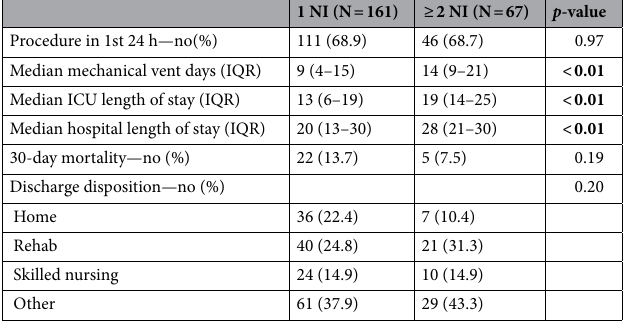
Table 6. Hospital resource utilization of one versus multiple NI. Significant values are in